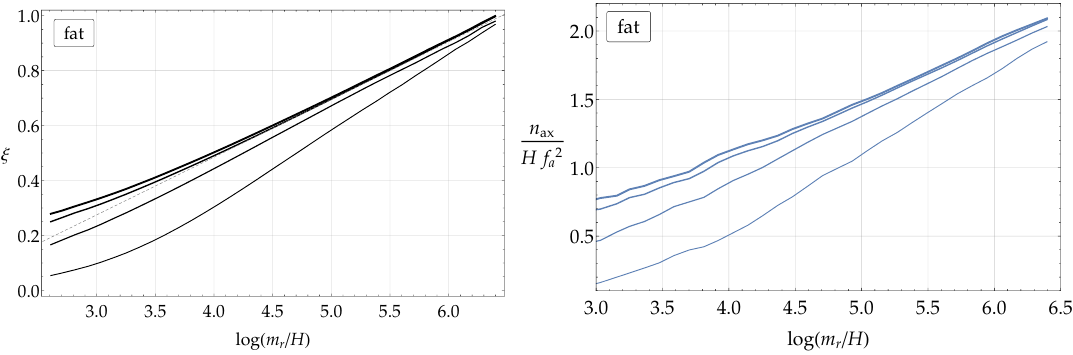
Figure 23 . Convergence to the attractor for (cid:24) ( t ) (left) and n a (right) for fat strings. Denser initial conditions are represented by thicker lines, and the results in both cases are obtained from the same sets of initial conditions, with (cid:12)xed string densities.